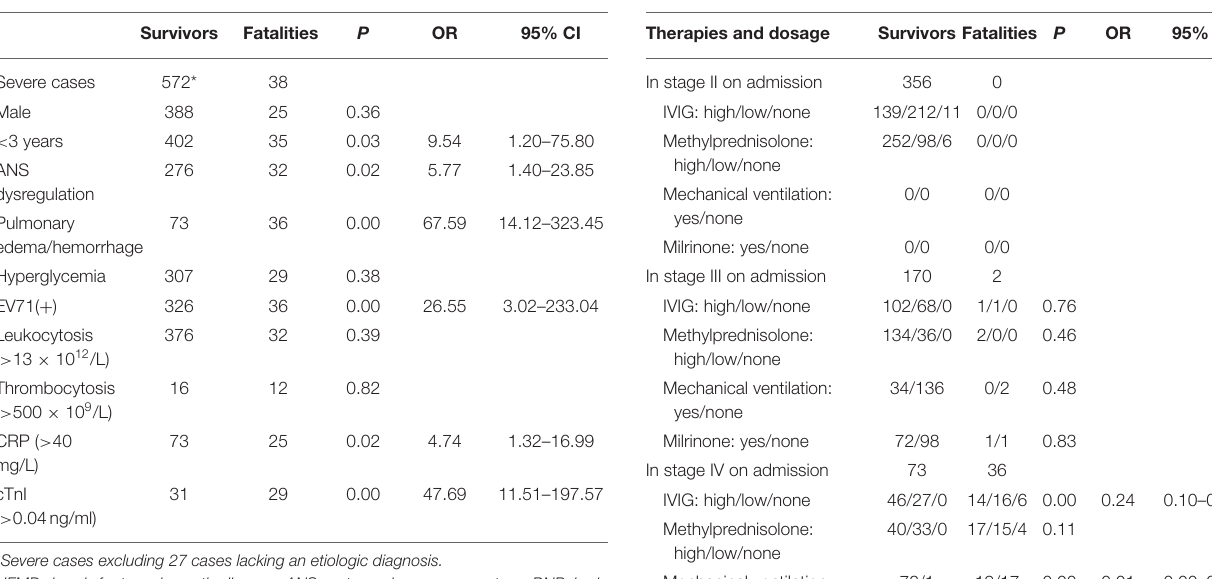
TABLE 2 | Risk factors analysis on the fatality of severe HFMD cases by binary logistic regression.